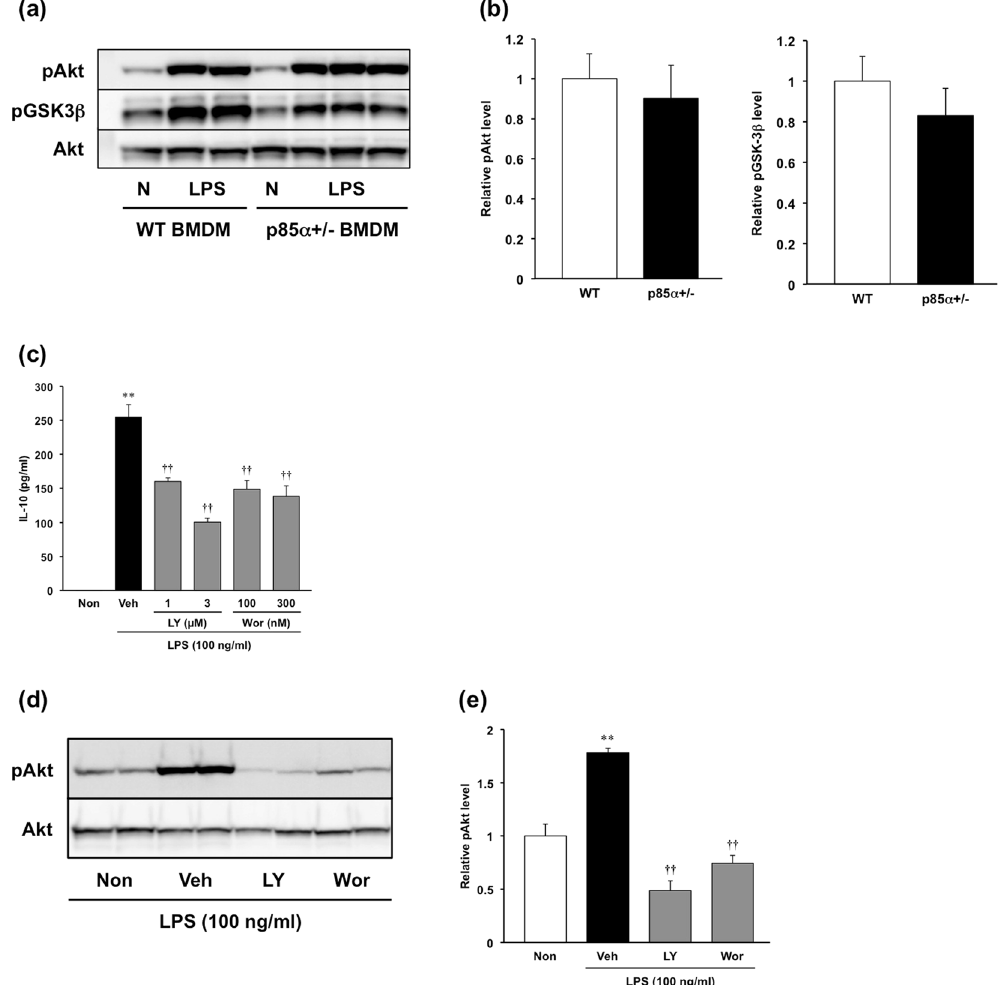
Figure 4. The production of a large amount of IL-10 in p85 α+ / − BMDMs is independent of Akt activation. BMDMs were prepared from the femurs and tibiae of WT or p85 α+ / − mice and cultured with M-CSF (100 ng/ ml) for 7 days. ( a ) Representative images of pAkt and pGSK-3 β protein level in WT or p85 α+ / − BMDMs as detected by western blotting. BMDMs were stimulated with LPS (100 ng/ml) for 1 h. ( b ) Relative pAkt and pGSK-3 β levels were normalized by Akt signals. ( c ) Effect of LY294002 and wortmannin on the concentration of IL-10 in the culture supernatant of WT BMDMs. LY294002 (1–3 μ M) and wortmannin (100–300 nM) was applied 30 min before LPS stimulation. ( d ) Representative images of pAkt protein level in LY294002 (LY) or wortmannin (Wor)-treated BMDMs as detected by western blotting. ( e ) Relative pAkt levels were normalized by Akt signals. The data are presented as the mean ± SE of 4 independent experiments. ** p < 0.01, compared with non-stimulation (Non). †† p < 0.01, compared with vehicle